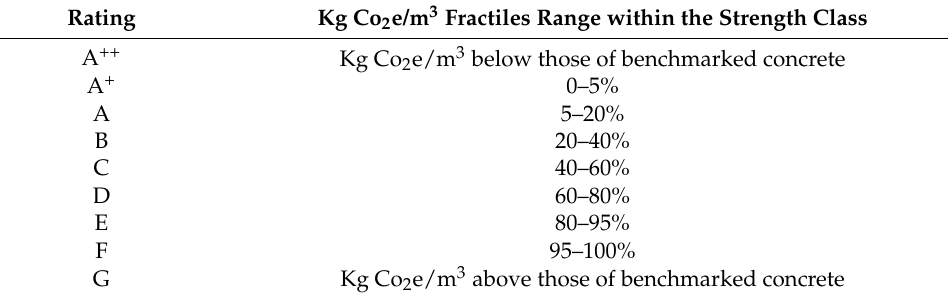
Table 5. Distribution of embodied carbon fractiles (kg CO 2 e/m 3 )